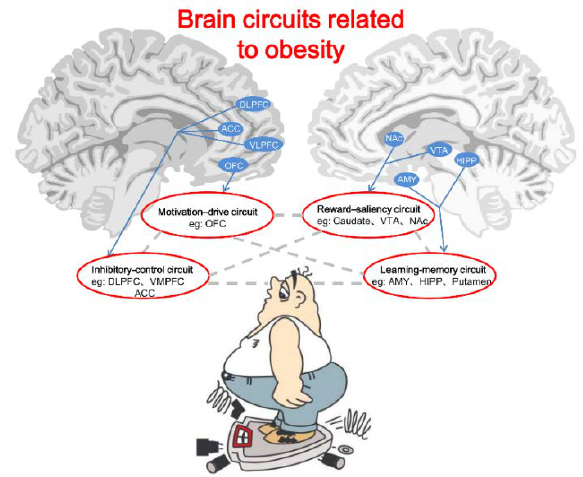
Figure 1. Brain circuits related to obesity. The circuits include motivation-drive (e.g., OFC), reward-saliency (e.g., VTA and NAc), inhibitory-control (e.g., DLPFC, ACC, and VMPFC) and learning-memory (e.g., AMY, HIPP, and Putamen). Gray dotted lines represent functional interactions between the brain circuits. In this model, during exposure to the reinforcer ( i.e. , foods) or to the cues conditioned to the reinforcer, there appears to be an obesity-related lower perception of reward (processed by the learning-memory circuit), which promotes overactivation of the reward-saliency and motivation-drive circuits while decreasing the inhibitory-control circuit activity. The overall outcome in obese persons is a lessened ability or an inability to inhibit the drive to seek and consume